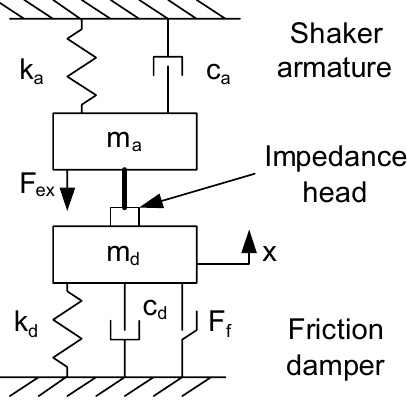
Fig. 8. Model of the shaker armature and the friction